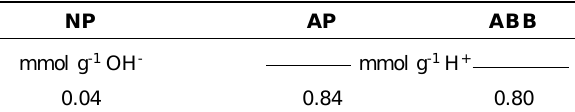
Source: Corrêa (2006).